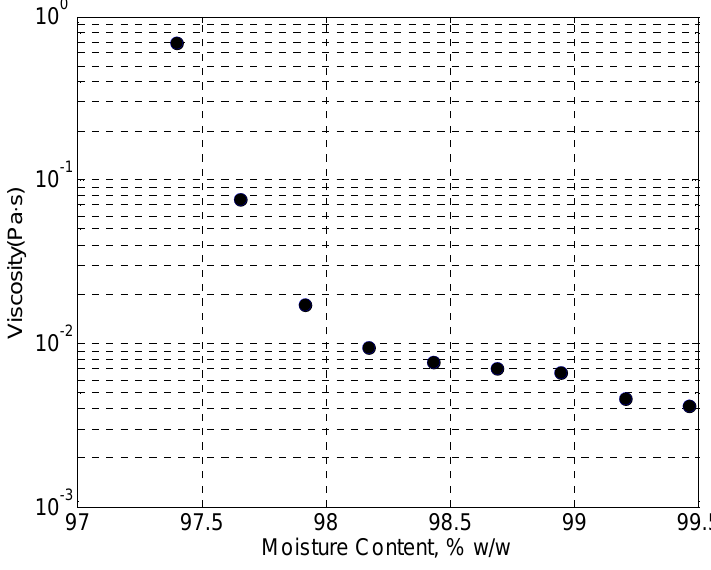
Figure 1. Viscosity of the jelly as a function of moisture content.